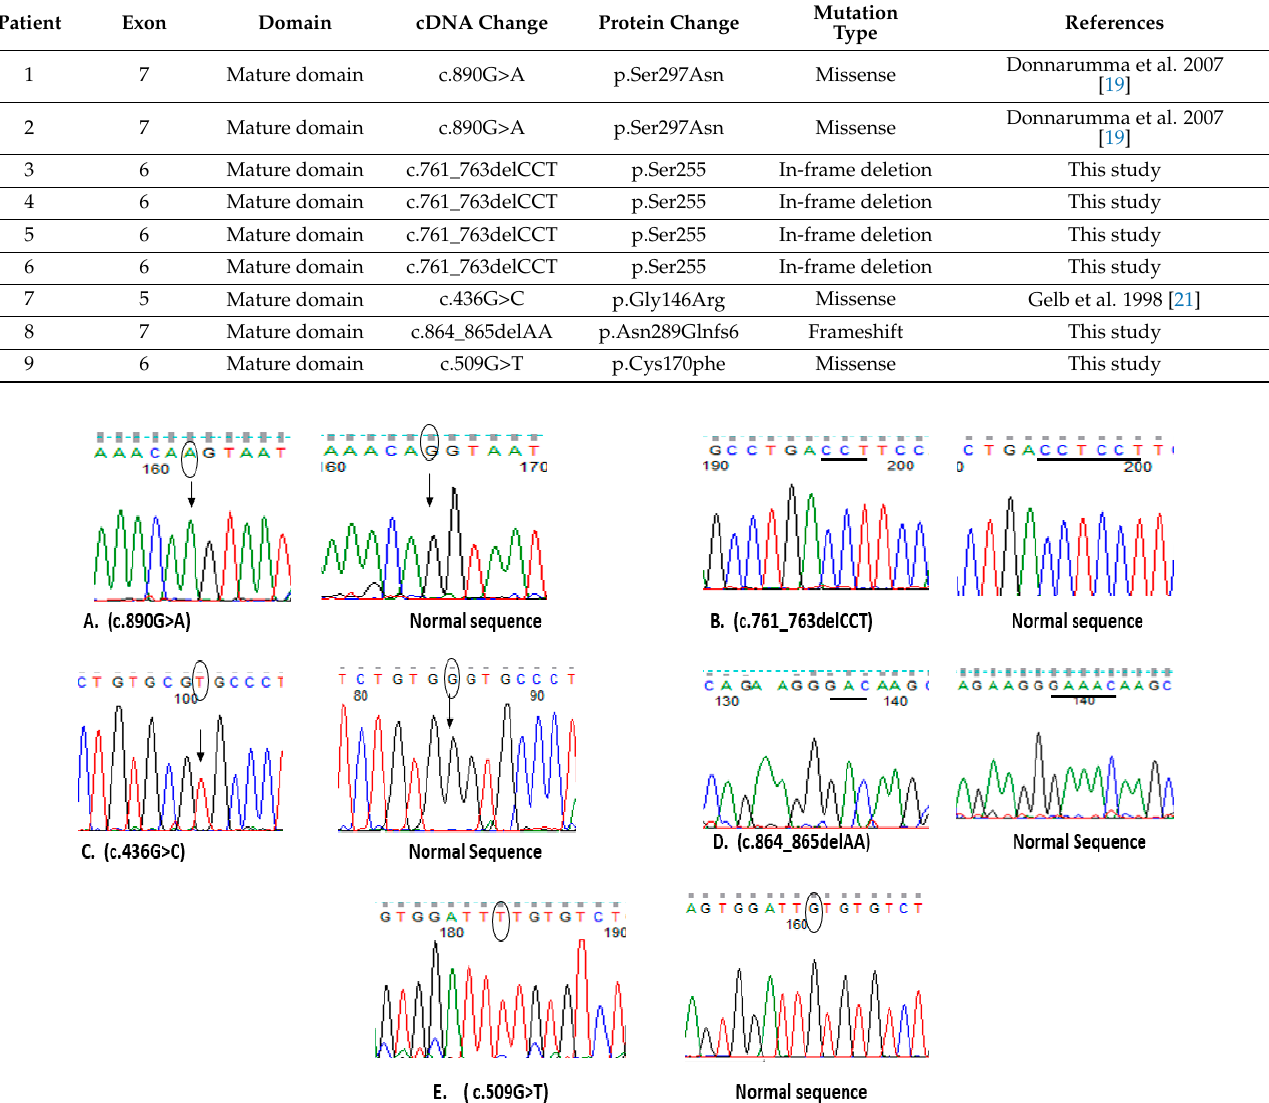
Table 4. The characteristics of CTSK gene mutations in this study.